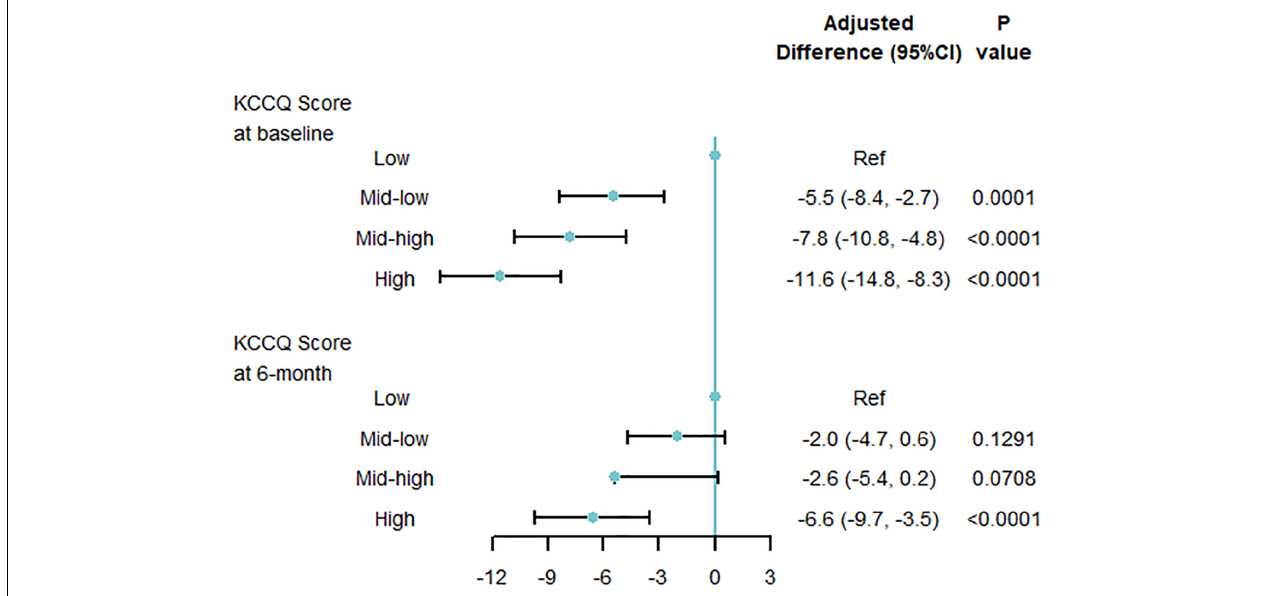
FIGURE 4 | Quality of life by multi-biomarker point groups (validating cohort). KCCQ, Kansas City Cardiovascular Questionnaire; CI, confidential interval. Only including 3433 patients with KCCQ score at 6-month